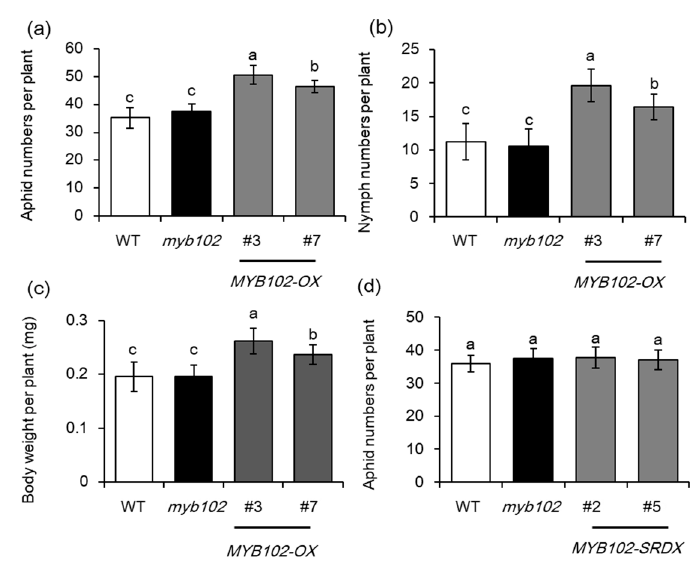
Figure 3. Overexpression of MYB102 increases Arabidopsis susceptibility to aphid infestation. ( a ) Aphid population size (adults plus nymphs) reared on the WT, myb102 , and MYB102-OX lines ( n = 10) after 48 h of infestation. ( b ) The number of progeny from initially one female per plant was measured after 10 days of nymph infestation ( n = 10). ( c ) Average body weight of adult aphids on the WT, myb102 , and two independent MYB102-OX and –SRDX lines ( n = 10) after 48 h of infestation ( d ) Aphid population size on the WT, myb102 , and two independent MYB102-SRDX lines ( n = 10) after 48 h of infestation. Different letters above bars denotes significant difference among different treatments using Tukey test at p < 0.05.